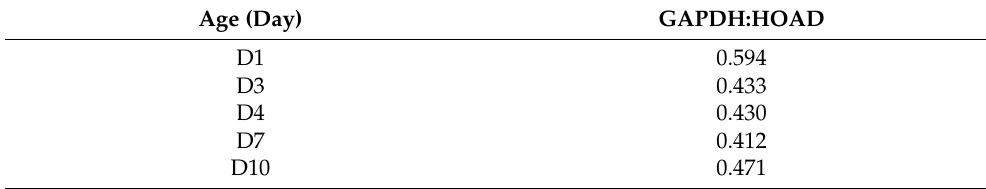
Table 3. The activity ratio of GAPDH:HOAD in S. frugiperda at different ages. Age (Day) GAPDH:HOAD D1 0.594 D3 0.433 D4 0.430 D7 0.412